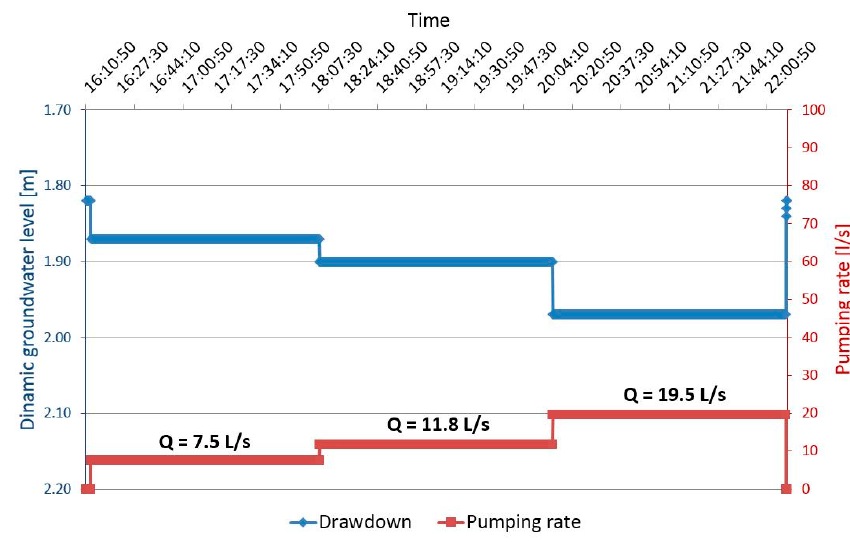
Figure 12. Drawdown in the pumping well Z-1 for step test.